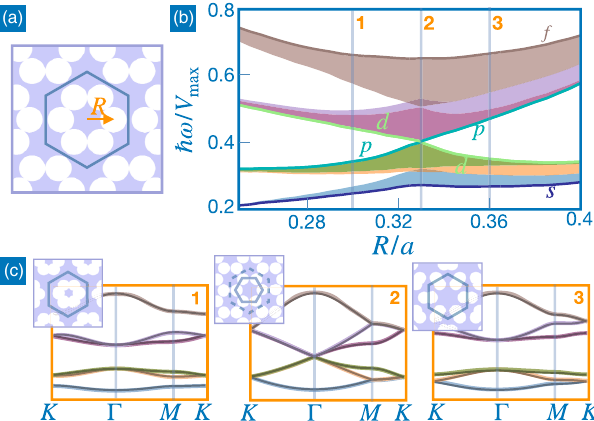
FIG. 2. Designing a band inversion for topological transport using rapid band-structure evaluation and symmetry predictions provided by a neural network. (a) Geometry of the potential: Six circular holes of fixed radius are placed at a varying distance R from the C 6 center. (b) Energy spectrum at the Γ point as a function of R .Theenergiesofthe p and d bandscrossfor R ¼ a= 3 .(c)Band structure for three different values of R [marked in panel (b) by the horizontal lines] before, at, and after the band-inversion transition (thick lines, NN; thin lines, SEq). The corresponding potentials are shown as insets. At the band-inversion transition, the Wigner-Seitz primitivecell becomes smaller. The resulting folded band structure supports a pair of degenerate Dirac cones at the Γ point. Moreover, two pairs of bands become degenerate along the k path from M to K . These are essential degeneracies enforced by the rotational symmetry and the smaller unit cell. The NN is able to reproduce these features, although it has not been trained on potentials with a smaller unit